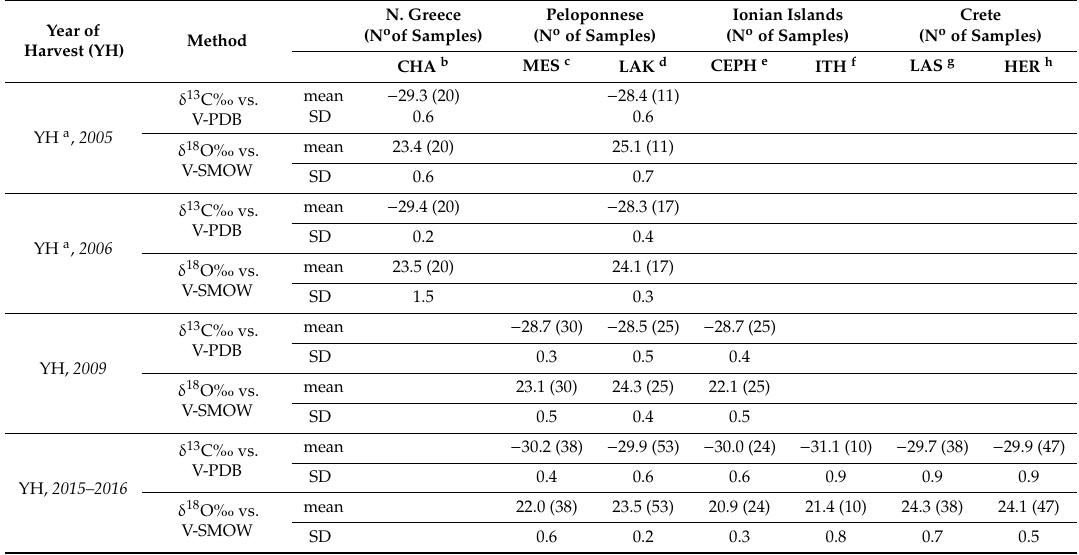
Table 2. The δ 13 C VPDB and δ 18 O VSMOW isotopic values of Greek olive oils expressed as mean values. Year of Harvest